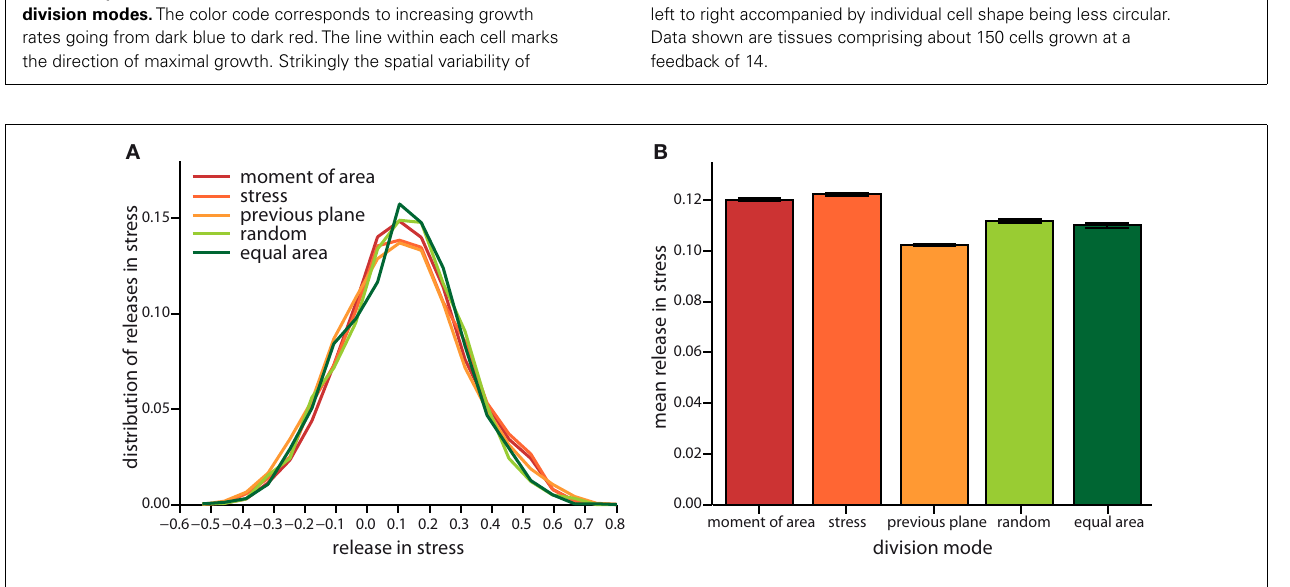
maximum principal second moment of area. Equally but less stress is released for random and equal area cell division modes. Cell divisions perpendicular to the previous plane of cell divisions release least stress. Data shown comprises at least 35,000 individual cells for each division mode.The qualitative trend is almost independent of feedback, see FigureA3 in the Appendix, data displayed is for a feedback of